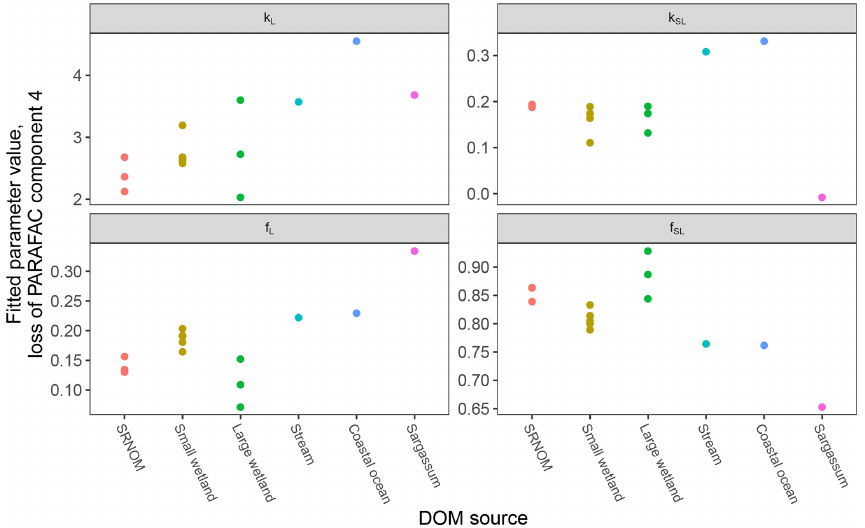
Figure 9. Fitted biexponential model parameters (Eq. 3) from the time series of PARAFAC component four (see Fig. 9 for data). f is unitless, and k is m 2 [molphotons] − 1 . For wetland samples, shapes represent different sampling dates (circles are 4 October 2017, triangles are 20 December 2017, and squares are 1 April